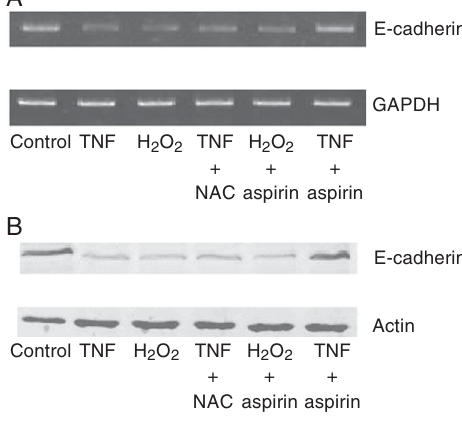
Figure 4. Inhibition of nuclear factor kappa B (NF κ B) but not of reactive oxygen species pre- vents tumor necrosis factor- α (TNF- α )-induced migration. In Boyden chamber assays, MCF- 7 cells were pretreated with as- pirin, N-acetyl cysteine (NAC) or control agent for 2 h in the volume indicated in Material and Methods. Cells were then